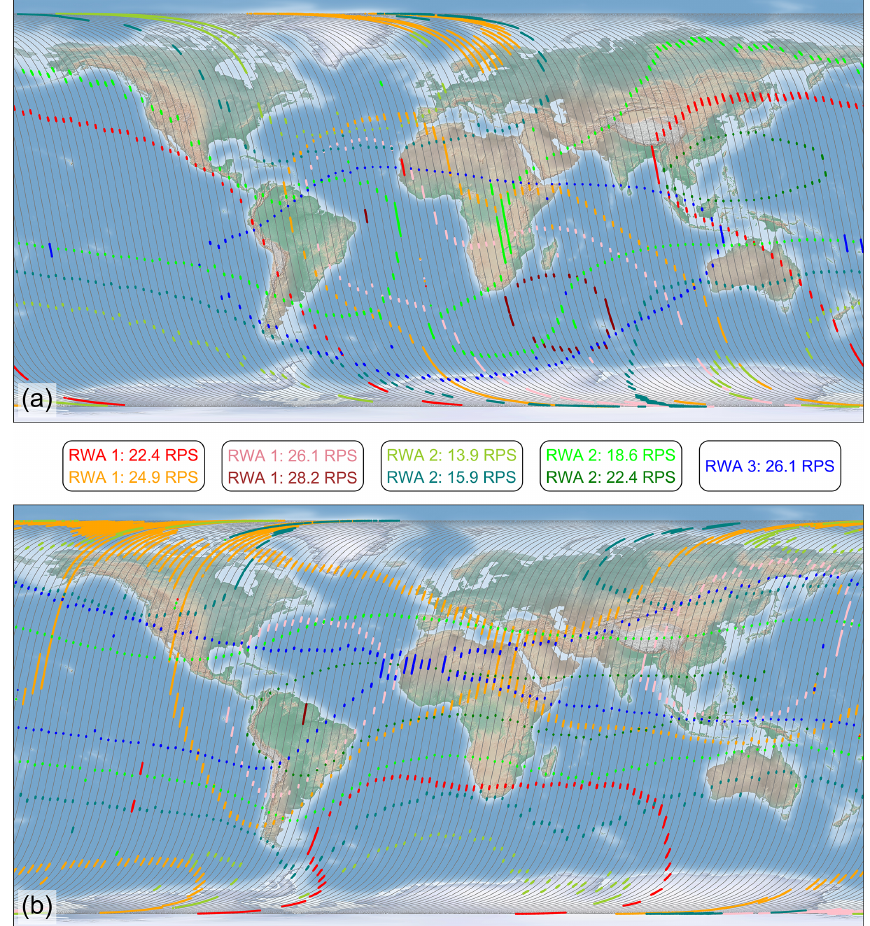
Figure 9. Geolocation of the most critical frequencies of the three active reaction wheels for (a) ascending and (b) descending orbits. The plot contains the data from the week between 14 October 2019 (00:00UTC) and 21 October 2019 (00:00UTC) (see also Fig. 6 for the corresponding frequency stability). Each dot corresponds to one observation (12s), for which one of the wheels operates at one of the critical wheel speeds as listed in bold type in Table